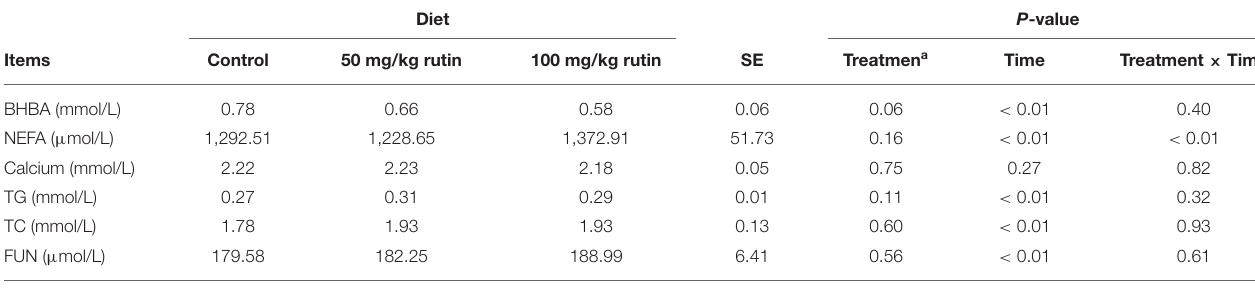
TABLE 3 | Effects of rutin supplementation to Hu sheep from − 14 through 28 d around parturition on biomarkers of nutrient metabolism. Diet P -value